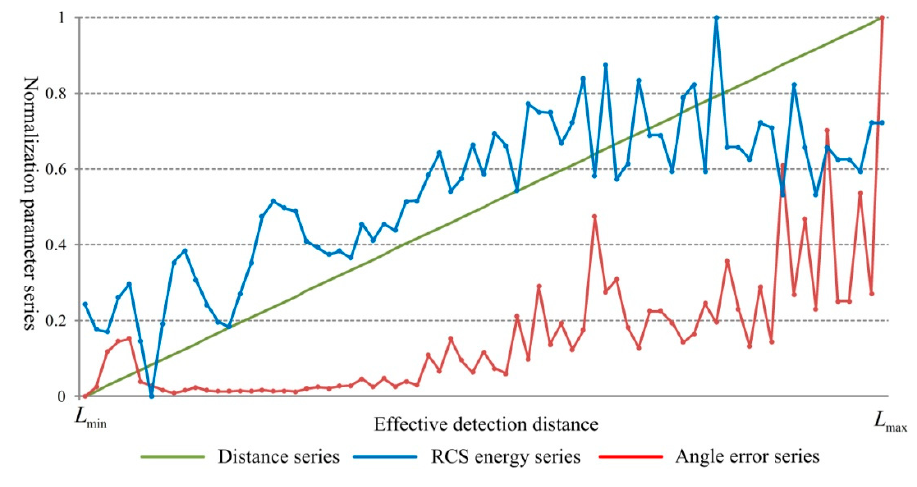
Figure 17. Data series variation.